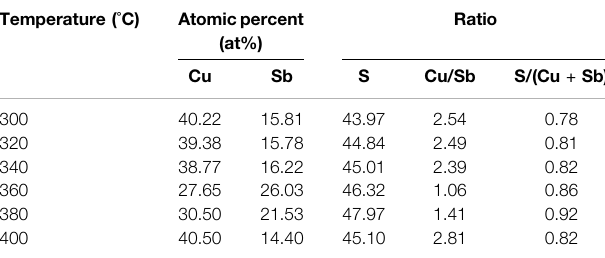
TABLE 2| Elemental compositionsofthin fi lmsannealedatdifferenttemperatures measured via EDS. Temperature ( ° C)